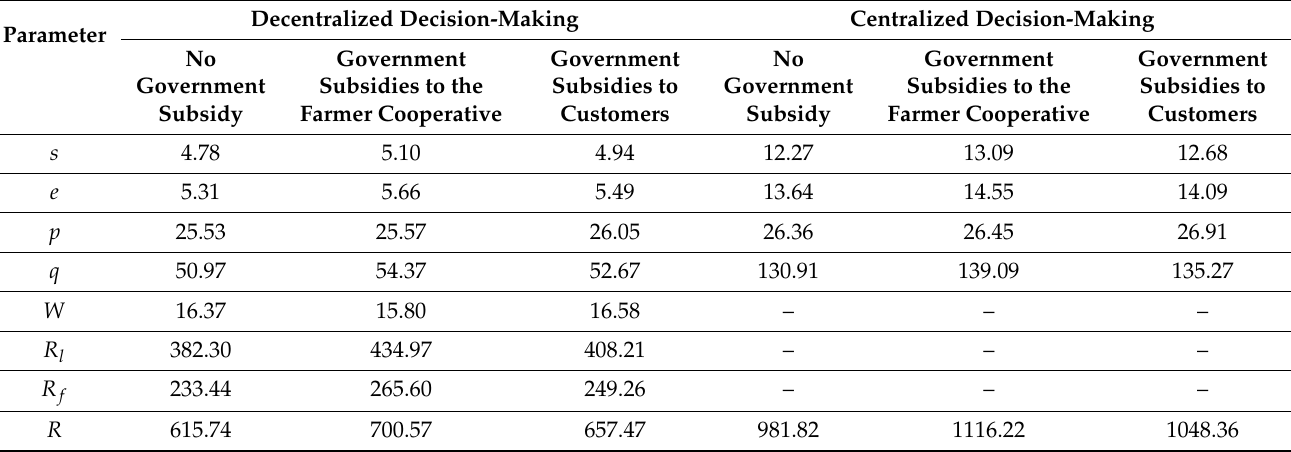
Table 8. Optimal decision and profit of different government subsidy strategies.